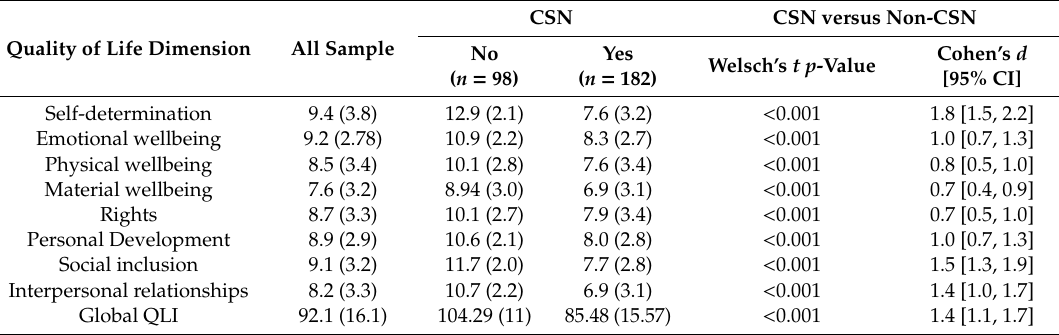
Table 4. Mean (SD) standard quality of life scores by dimension and